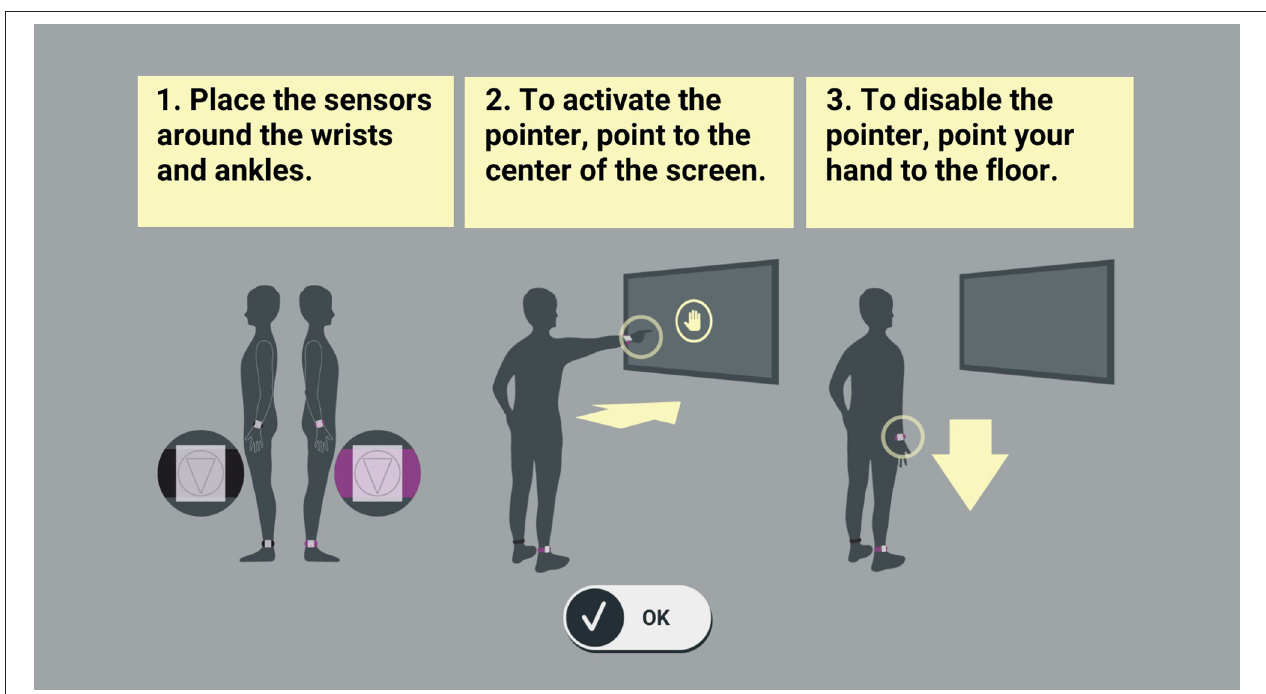
FIGURE 1 | Set up and navigation in the Active@Home exergame. The hardware of the Active@Home exergame consists of four inertial measurement units (IMUs). For movement evaluation, participants wore the sensors at wrists and ankles. Color and size of the bracelet helped to distinguish the position of each IMU. The IMUs were connected via Bluetooth to a HDMI dongle. This dongle was inserted into a television and provided the exergame software. The game interface was presented on the TV screen. By pointing the IMU on the right wrist horizontally to the TV screen, a “hand mouse” got activated for navigation through the game.